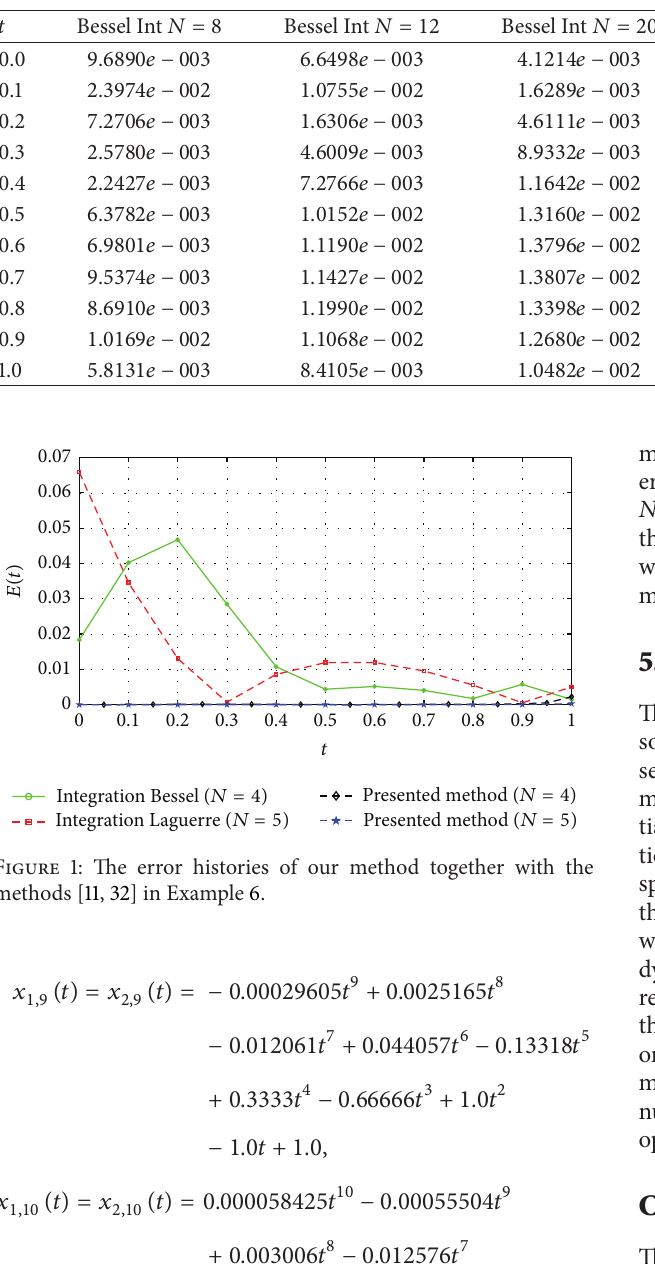
Table 4: The error histories at the selected points for Example 6.